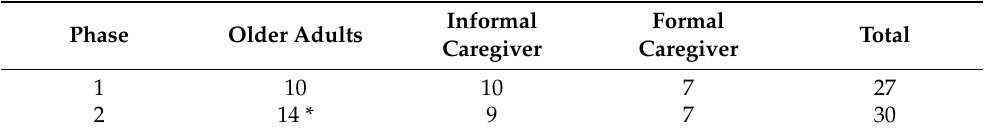
Table 5. Number of